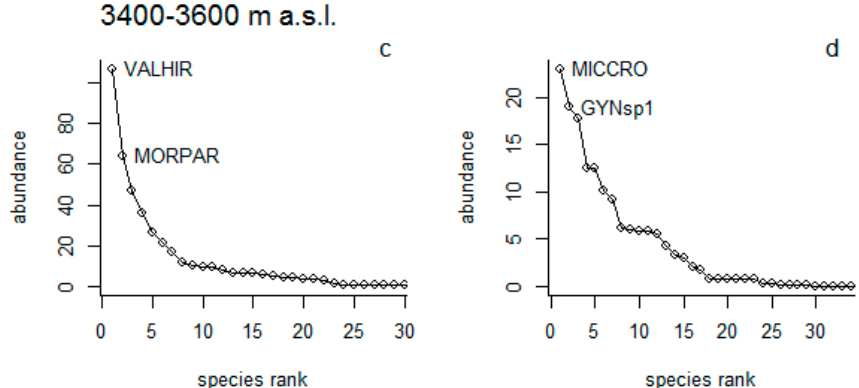
Figure 5. Woody species abundance rank at natural grassland (NG) cover ( a , c ) and pine plantation (Pi) cover ( b , d ) across three di ff erent elevational gradients (3200–3400 and 3400–3600 m a.s.l.). MORPAR = Morella parvifolia , MYRDEP = Myrsine dependens , MICTHE = Miconia theaezans , VALHIR = Valeriana hirtella , MICCRO = Miconia crocea , GYNsp1 = Gynoxys sp.